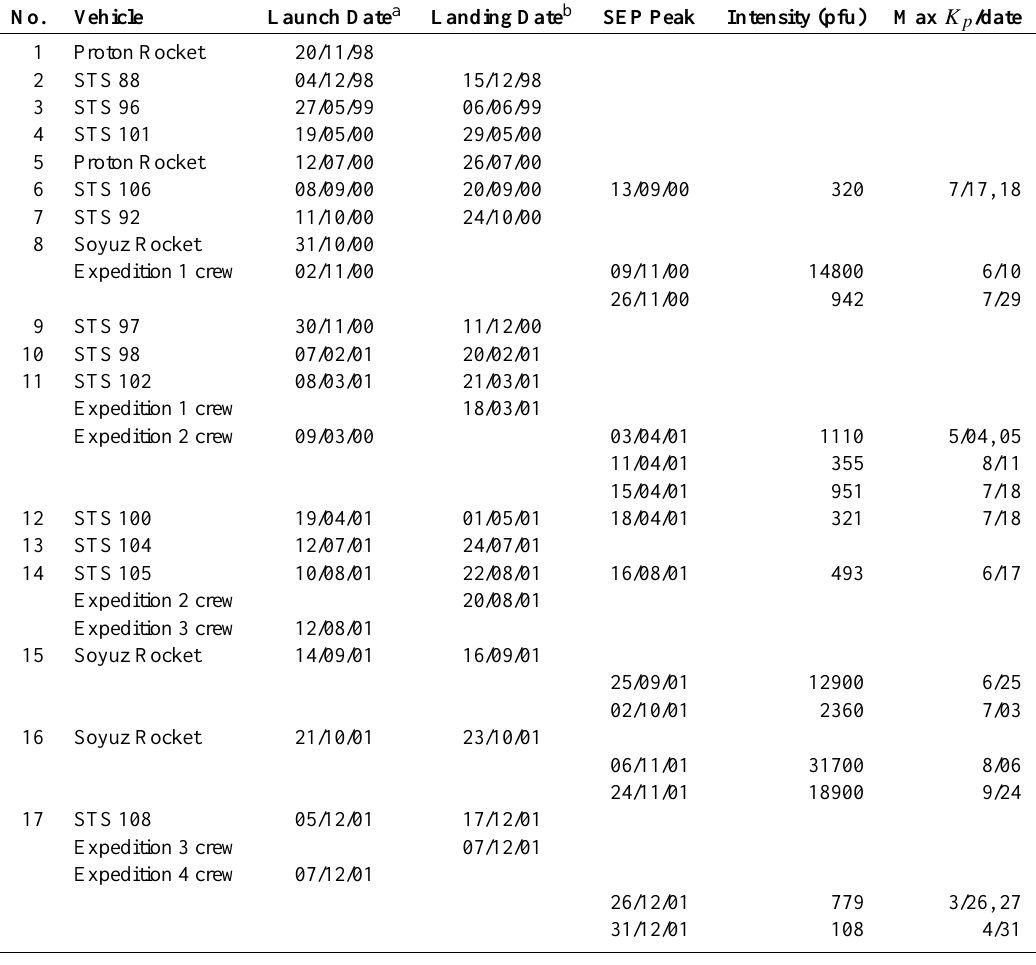
Table 1. ISS flights and SEP events